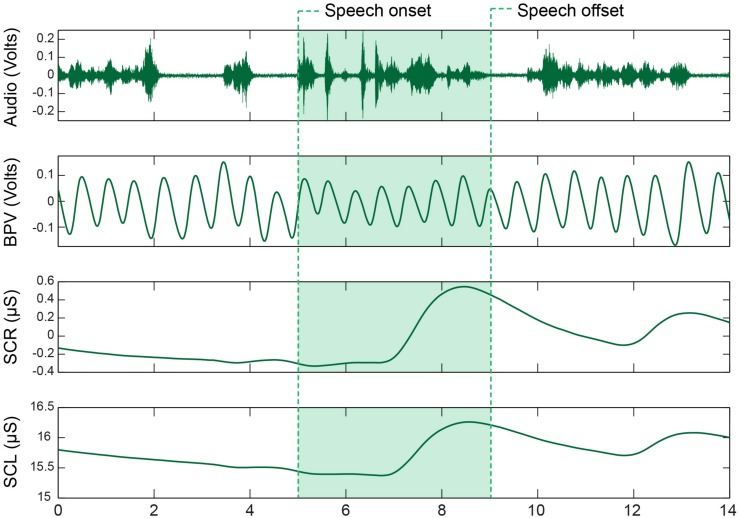
Sympathetic nervous system (SNS) recordings from a CWS during the picture description task. The waveforms represent, from top to bottom, the acoustic signal, blood pulse volume (BPV) signal, phasic skin conductance response (SCR), and tonic skin conductance level (SCL). Utterances were extracted from the long recording by identifying speech onsets and offsets within the acoustic record.